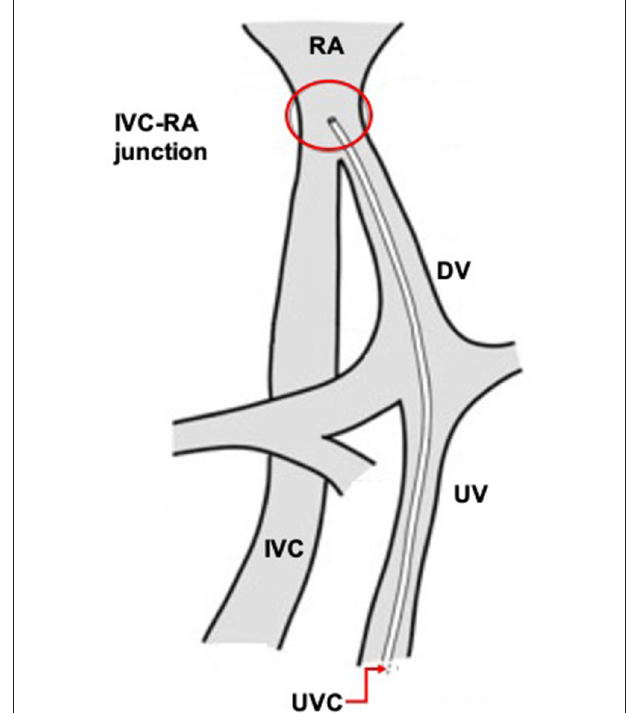
FIGURE 1 | Correct umbilical venous catheter position.